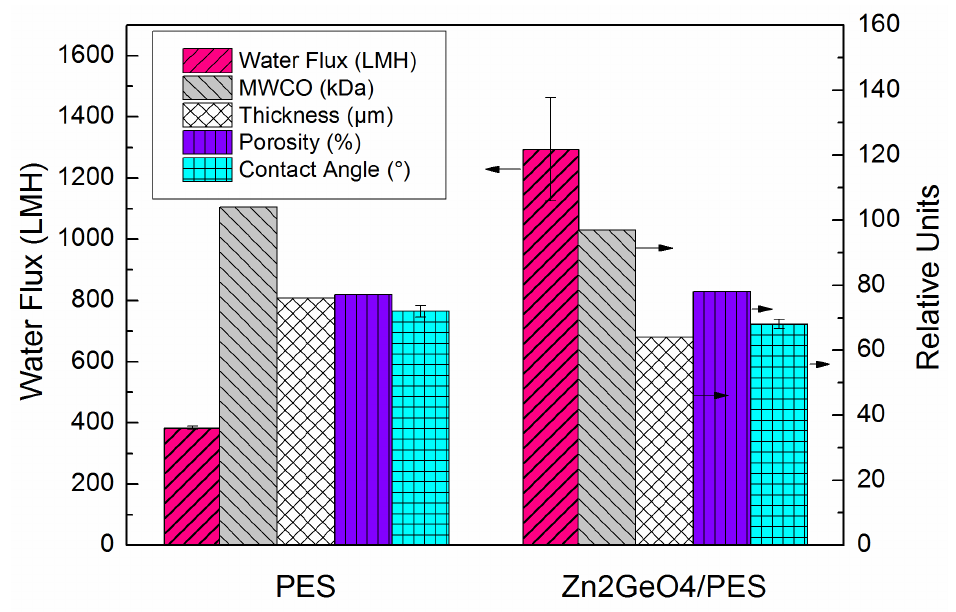
Figure 2. Ultrafiltration (UF) performance, thickness, porosity and contact angle of pristine polyethersulfone (PES) membrane and Zn 2 GeO 4 /PES